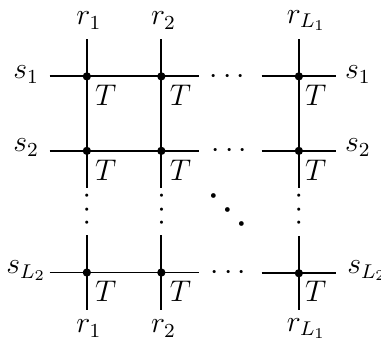
Figure 2 . The tensor network representing the partition function